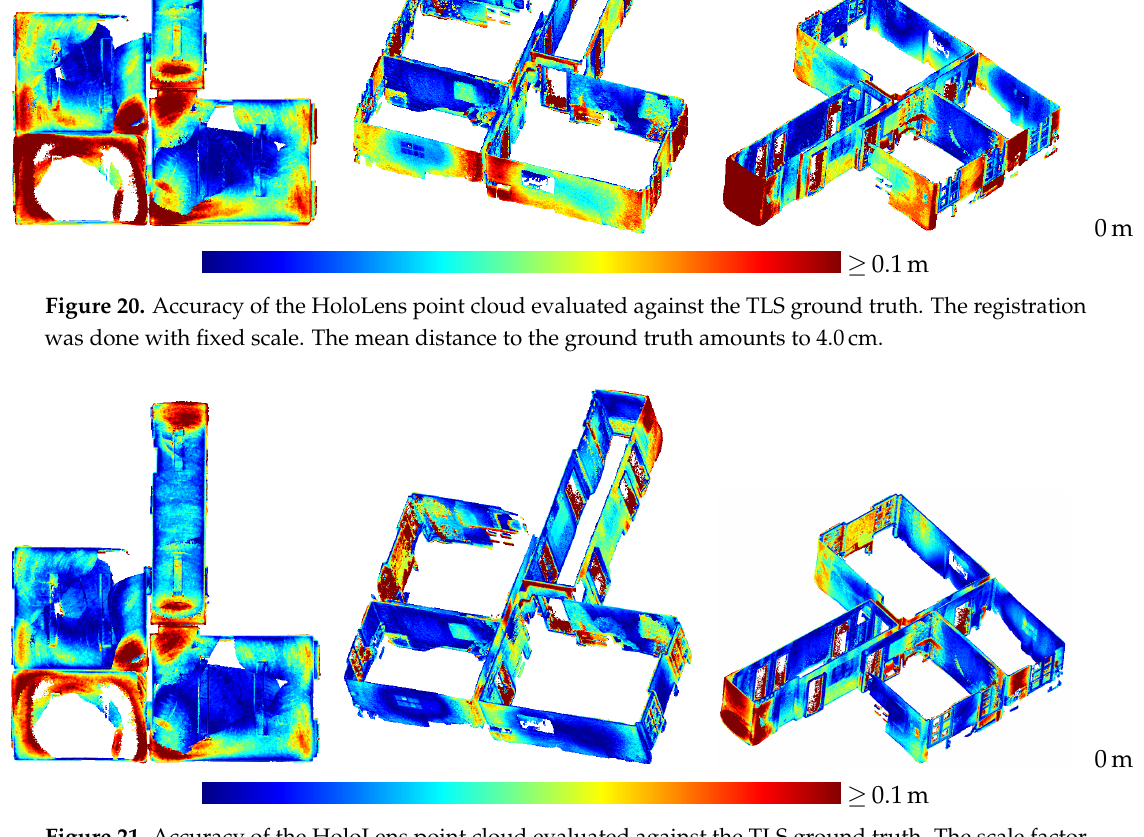
Figure 21. Accuracy of the HoloLens point cloud evaluated against the TLS ground truth. The scale factor was determined to 0.9887 by registration. The mean distance to the ground truth amounts to